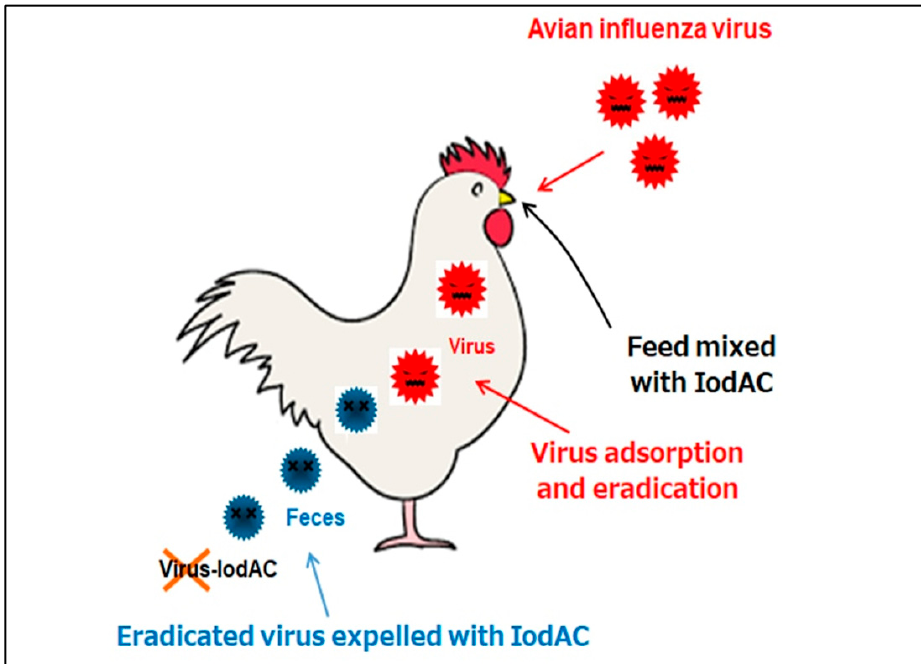
Figure 13. Potential application of IodAC in breeding farms for avian influenza prevention.